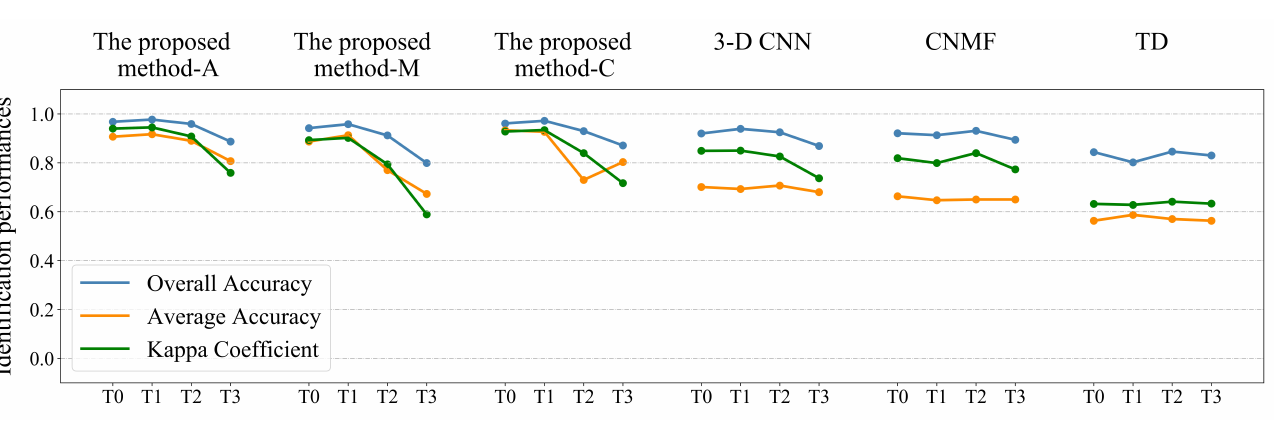
Figure 16. Identification performance chart of the simulated data (OA-AA-Kappa).